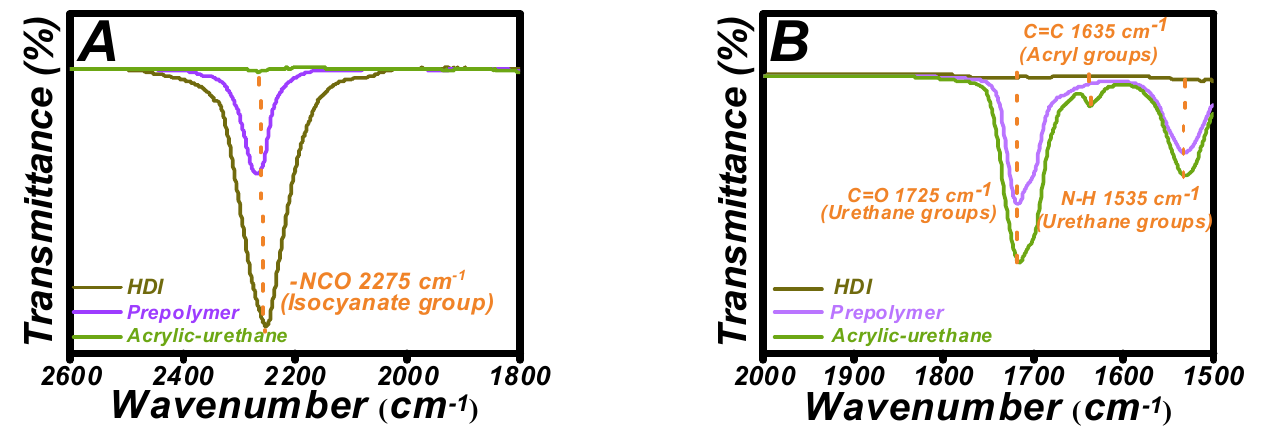
Figure 1. FT − IR spectra of triol acrylic-urethane by a reaction of NH groups ( A ) and C=O groups ( B ) and by the addition of 2-HEMA.